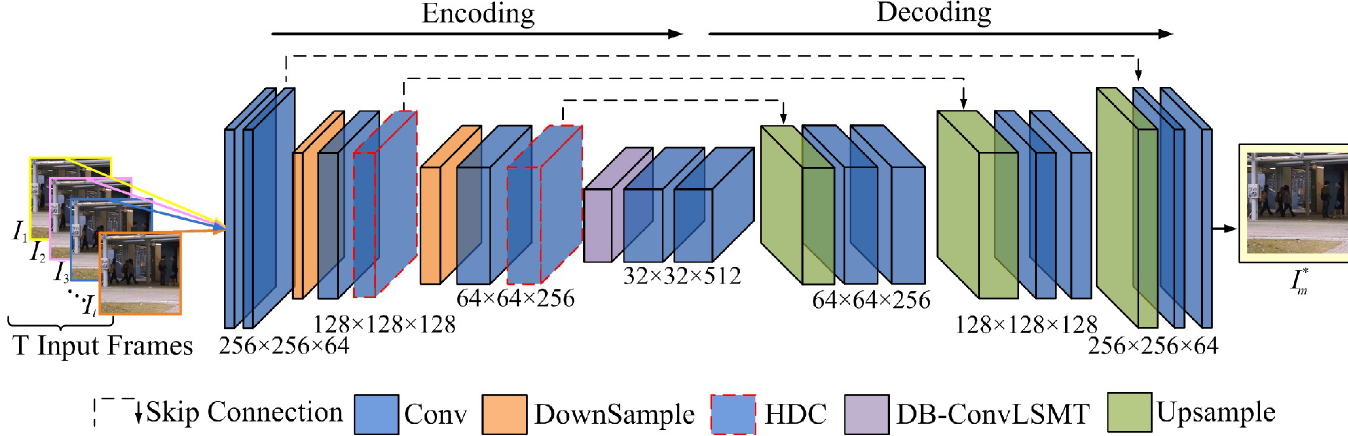
Fig 2. Structure of prediction module. The input and output size of the module are both 256 × 256 × 3. The kernel sizes of all convolution and deconvolution are set to 3 × 3 and the downsample layers are set to 2 × 2.The resolutions of feature maps are equal inthe same convolution layer.